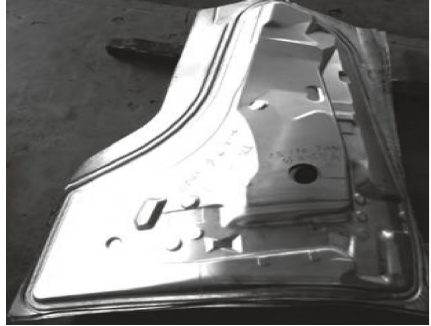
Figure 11: Pixel point spraying on the fender.